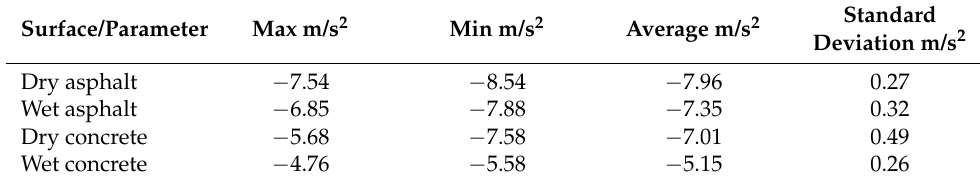
Table 2. Statistical characteristics of the acceleration value in the braking maneuvers of the urban bus.